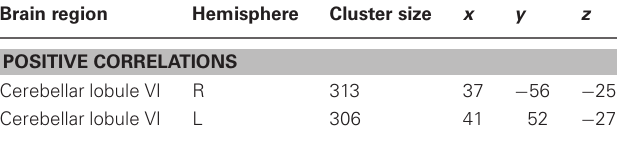
Table 2 | Regional activation for correlational analysis for sequence-specific weighted image for overall movement error (root mean square error; RMSE) difference scores (mean repeated − mean random) at retention.